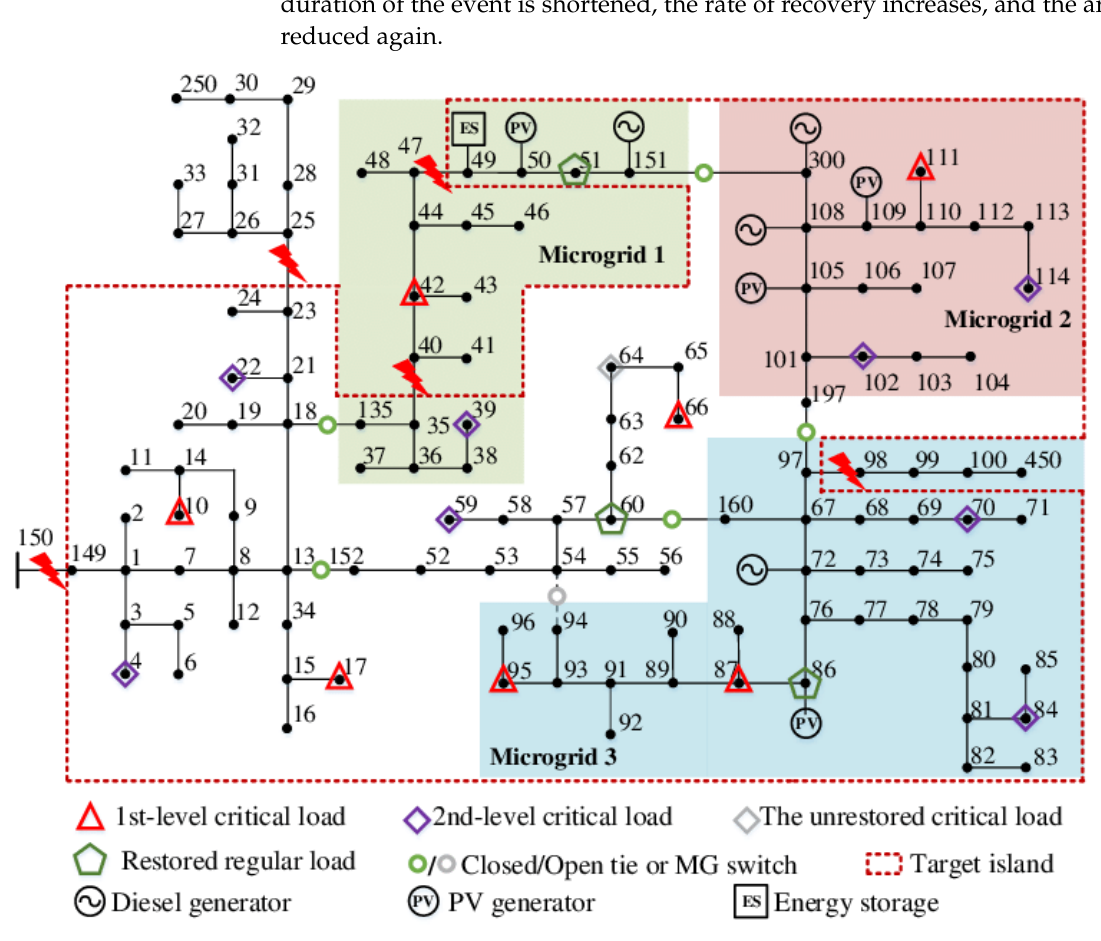
Figure 2. IEEE 123-node test system with three microgrids. Source: [77].